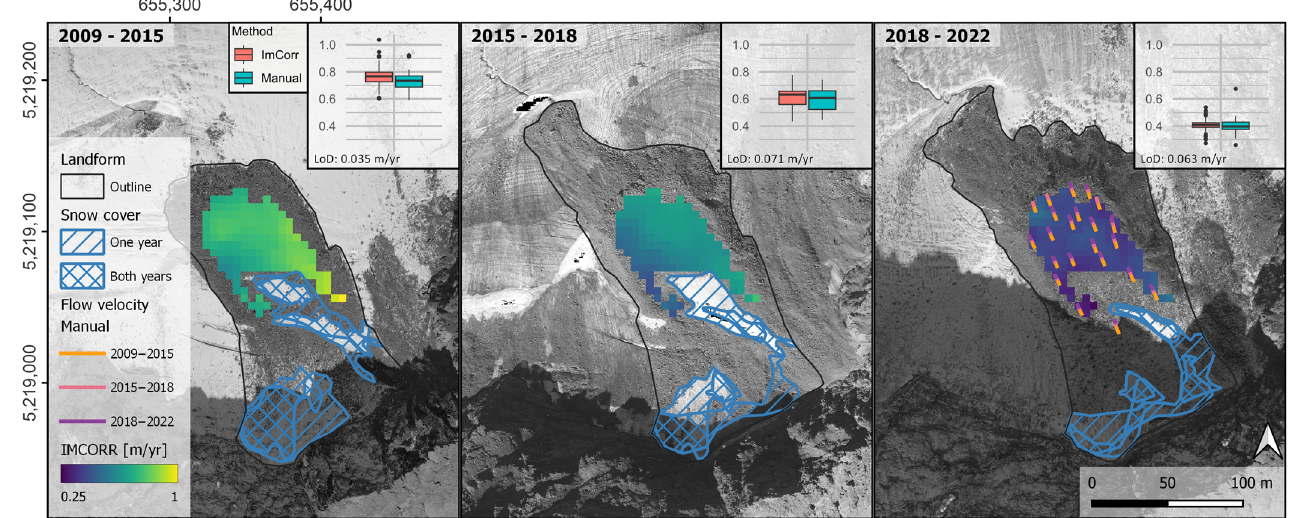
Figure 5. Flow velocity in different periods derived by manual mapping and image correlation (IMCORR). The landform outline and the orthophoto depict the first year of the respective period. In the upper-right corner of the individual maps, flow velocities of the period are displayed as boxplots with the unit m/year. The results of the manual mapping are shown for all periods in the map of the period 2018–2022.